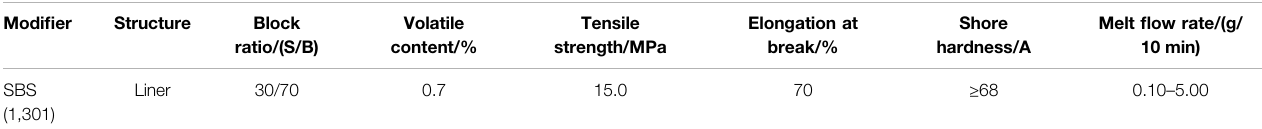
TABLE 2 | performance of SBS modi fi er.